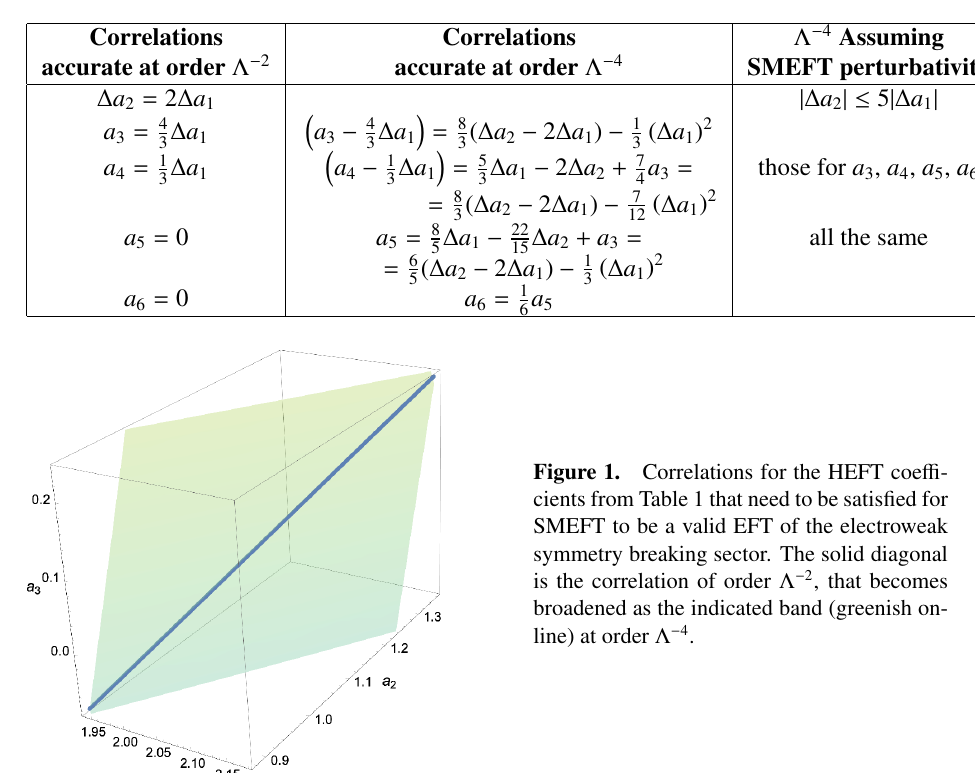
Table 1. Correlations among the a i HEFT coe ffi cients necessary for SMEFT to exist, at the orders Λ − 2 and Λ − 4 , given in terms of Δ a 1 : = a 1 − 2 = 2 a − 2 and Δ a 2 : = a 2 − 1 = b − 1 (so that all entries in the table vanish in the SM, with all equalities becoming 0 = 0). Notice that the r.h.s. of each identity in the second column shows the O ( Λ − 4 ) corrections to the relations of the first column. The third one assumes the perturbativity of the SMEFT expansion.